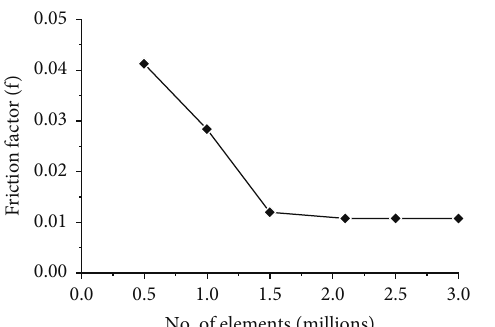
Figure 3: Grid independence study for the turbulent regime.